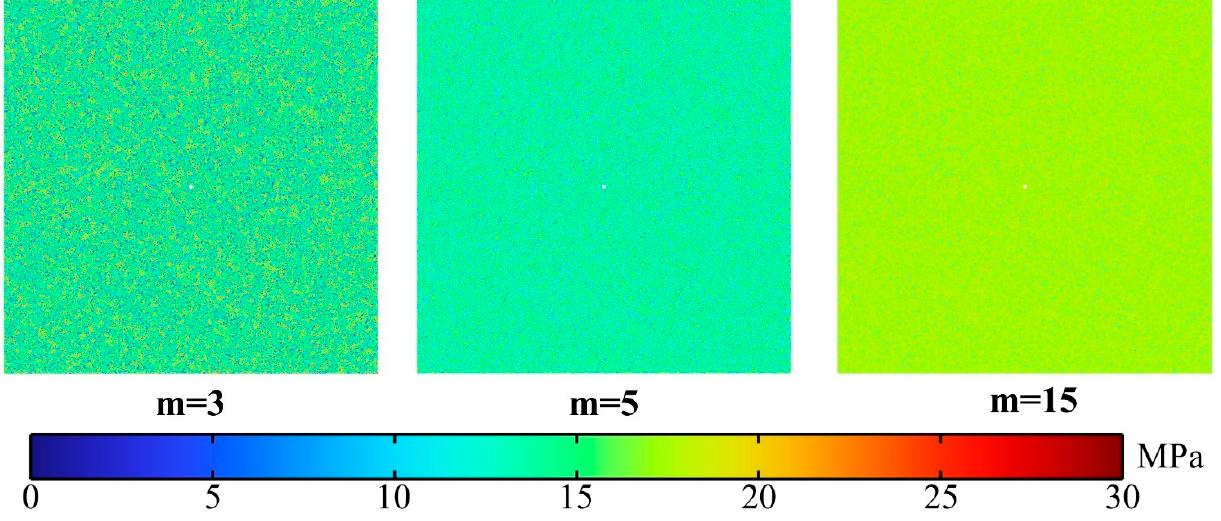
Figure 20. Cloud diagrams of the tensile strength of granite for different homogeneity indices m = 3, 5, 15.